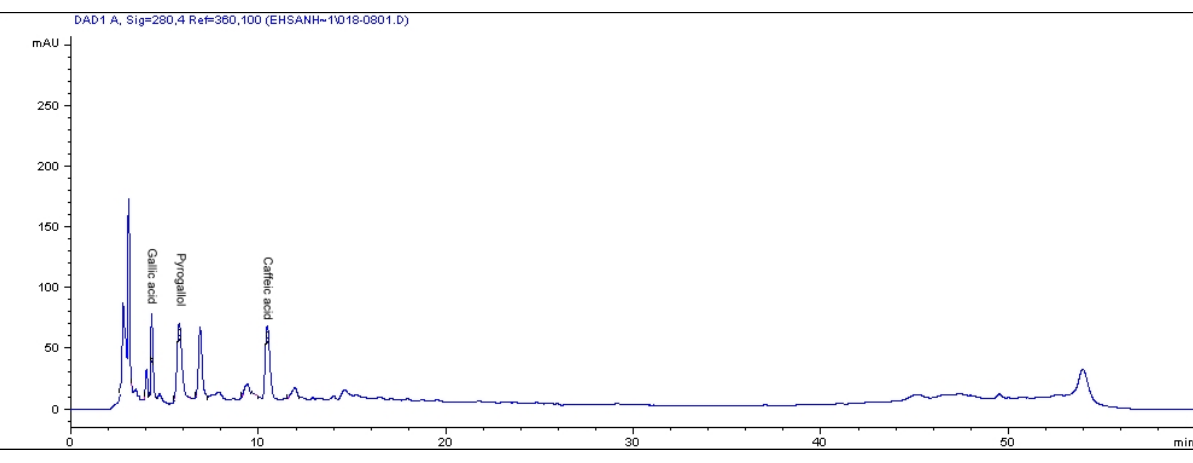
Figure 2. The RP-HPLC chromatogram of phenolic compounds in the leaves of Labisia pumila var. alata. Identification of compounds: gallic acid, pyrogallol and caffeic acid.